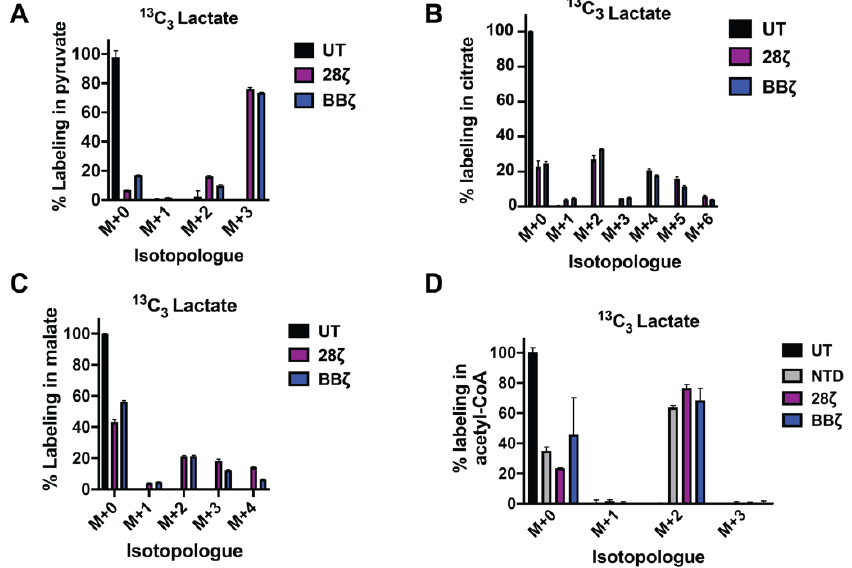
Figure 1. Lactate supports TCA cycle anaplerosis and short chain CoA synthesis in CAR T-cells. Activated CAR T-cells (day 7) were refed with RPMI medium, conditioned with 10% dialyzed FBS, and supplemented with 20 mM 13 C 3 lactate for 1 h. Mass isotopomer data for pyruvate ( A ) and citrate ( B ) are shown. Mean values ± S.E.M. from 3 technical replicates are shown. UT: untreated; 28 ζ : T-cells lentivirally infected with a 28 ζ CAR and treated with 13 C 3 lactate; BB ζ : T-cells lentivirally infected with a 4-1BB ζ CAR and treated with 13 C 3 lactate. ( C , D ) Activated T-cells (day 10) were refed with RPMI medium, conditioned with 10% dialyzed FBS, and supplemented with 20 mM 13 C 3 lactate overnight. Mass isotopomer data for malate and acetyl-CoA are shown. Mean values ± S.E.M. from 3 technical replicates are shown. NTD: nontransduced T-cells; 28 ζ : T cells lentivirally infected with a 28 ζ CAR and treated with 13 C 3 lactate; 28 ζ NOX: T-cells lentivirally co-infected with a 28 ζ CAR, as well as Lactobacillus brevis NADH Oxidase ( Lb NOX) and treated with 13 C 3 lactate BB ζ : T-cells lentivirally infected with a 4-1BB ζ CAR and treated with 13 C 3 lactate.